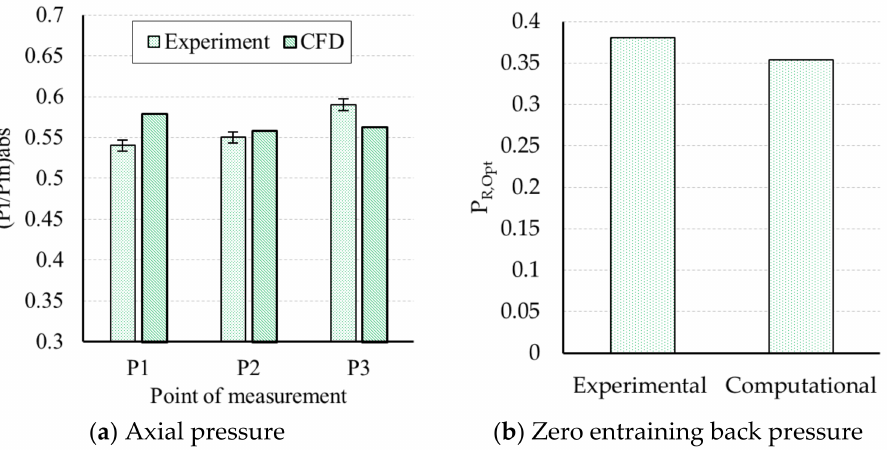
Figure 8. Comparison between experiment and computational study (random uncertainty of measurement = ±